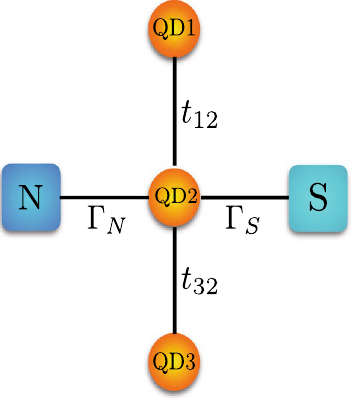
Figure 1. A sketch of triple-QD system coupled to normal metal and superconducting